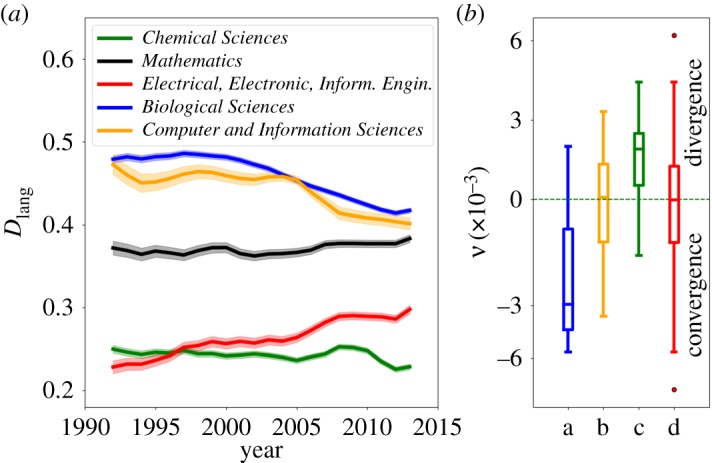
Evolution of the similarity between disciplines in the last three decades. (a) Distance Dlang(i,j) between Physical Sciences (i) and other five selected disciplines (j) (3-year moving averages). (b) Total variation ν—defined in equation (3.1)—of the distance for pairs of disciplines with histories longer than 12 years. Each boxplot corresponds to the distribution of ν for pairs of disciplines where we fixed one of the disciplines. At position (a) we fixed Computer and Information Sciences, at (b) Chemical sciences, at (c) Psychology and at (d) we used all pairs of disciplines.